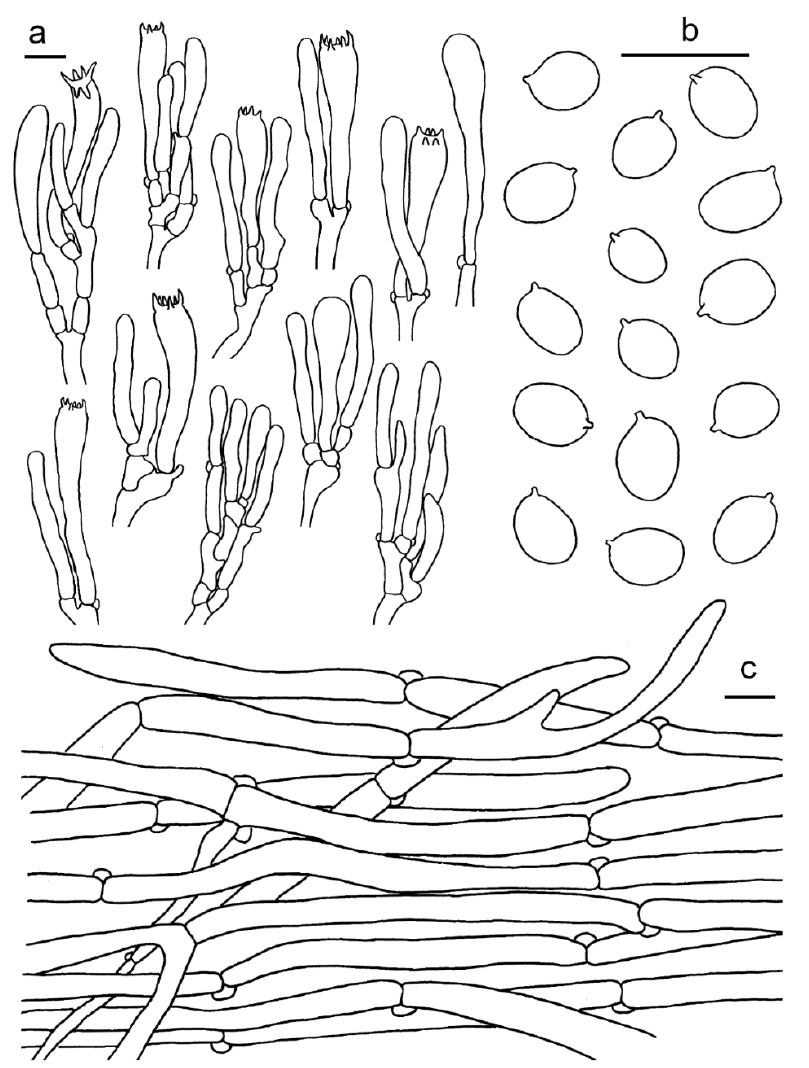
Figure 4. Cantharellus albus (GDGM56646). ( a ) Basidia, basidiola and elements of the subhymenium. ( b ) Basidiospores. ( c ) Pileipellis. Bars: ( a , b ) = 10 µ m; ( c ) = 20 µ m. Basidiospores (100/4/4) 5.5–7.5 × (4–) 4.5–6 µ m, L m × W m = 6.38 ( ± 0.54) × 4.89 ( ± 0.38) µ m, Q = (1.1) 1.2–1.45 (1.62), Q m = 1. 31 ± 0.11, broadly ellipsoid to subglobose,